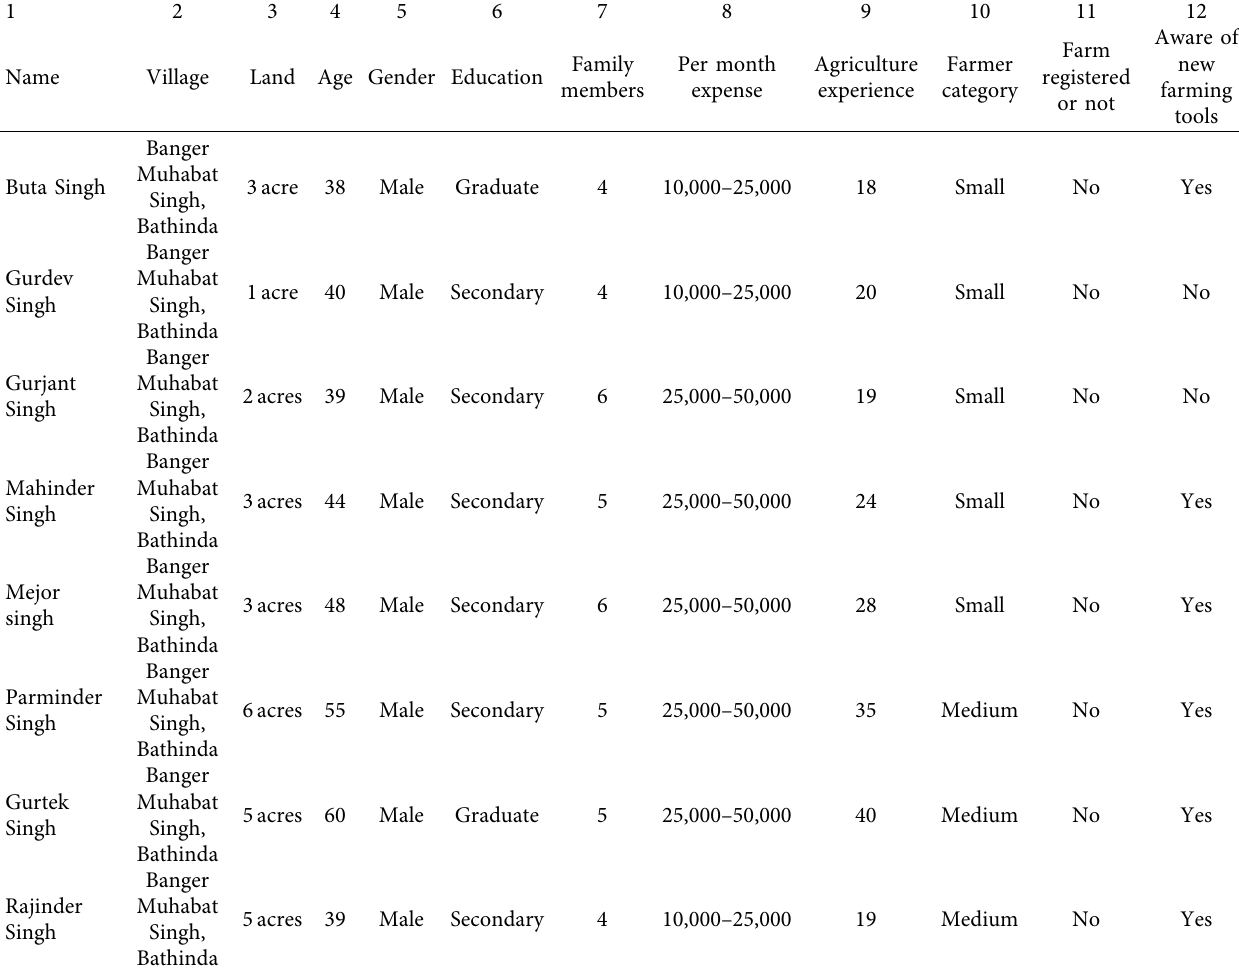
Table 1: Snapshot of sample collected data